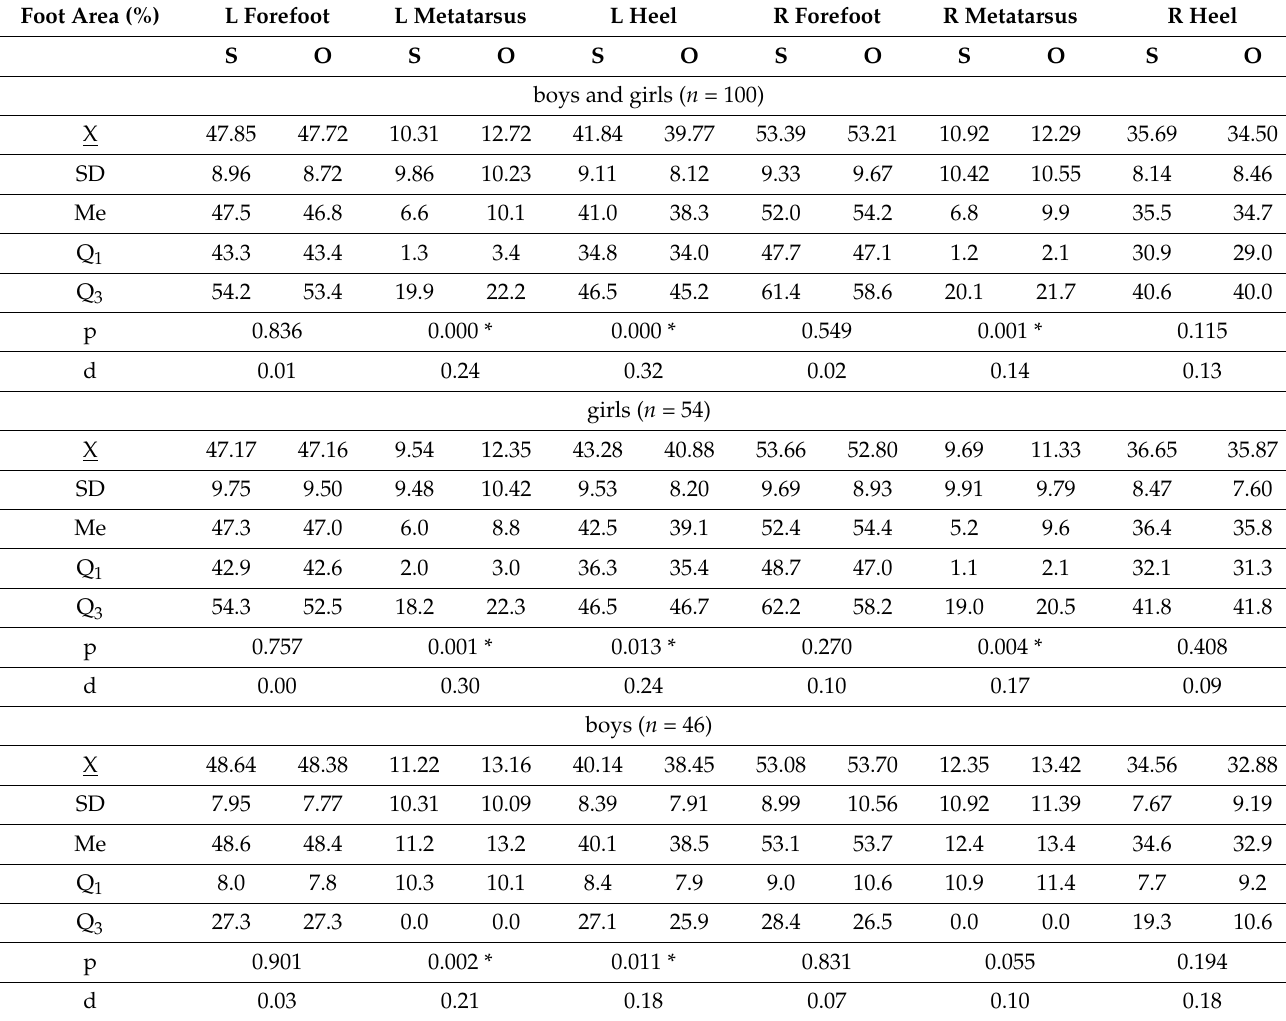
parameters of the studied populations, the Cohen effect size was small (Table 1). Table 1. Distribution of the results of the tests for the pressure of the foot on the ground at rest and after loading with a backpack in the study group; the Wilcoxon Matched Pairs